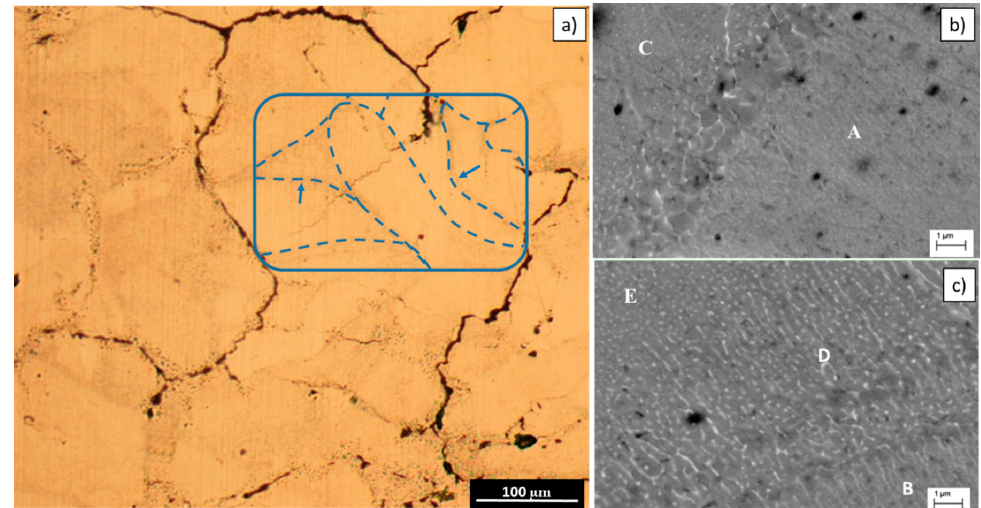
Figure 6. Overview of longitudinal-section of the deposit: ( a ) longitudinal-section morphology of ESD layer from top view showing sequence of deposition of ESD splats in the same plane of view (the arrow indicates the interface formed between the splat); ( b , c ) SEM images showing different zone with fine microstructure and splat-splat interface.